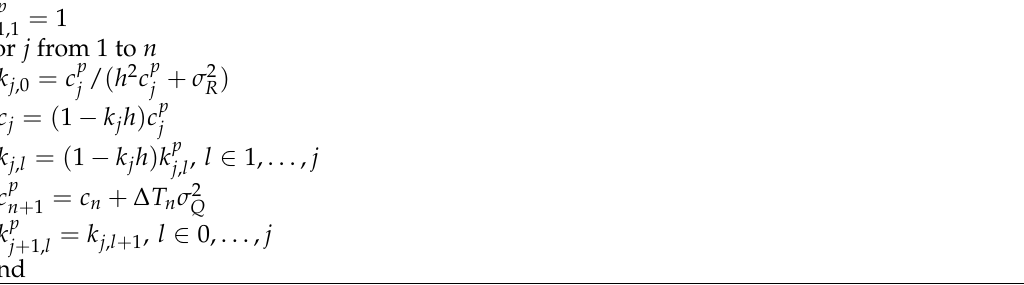
Algorithm 1 Computation of ideal Kalman filter gains on Poisson-distributed sequence. The gains do not depend on the actual measurements, so there is no need to include them in the